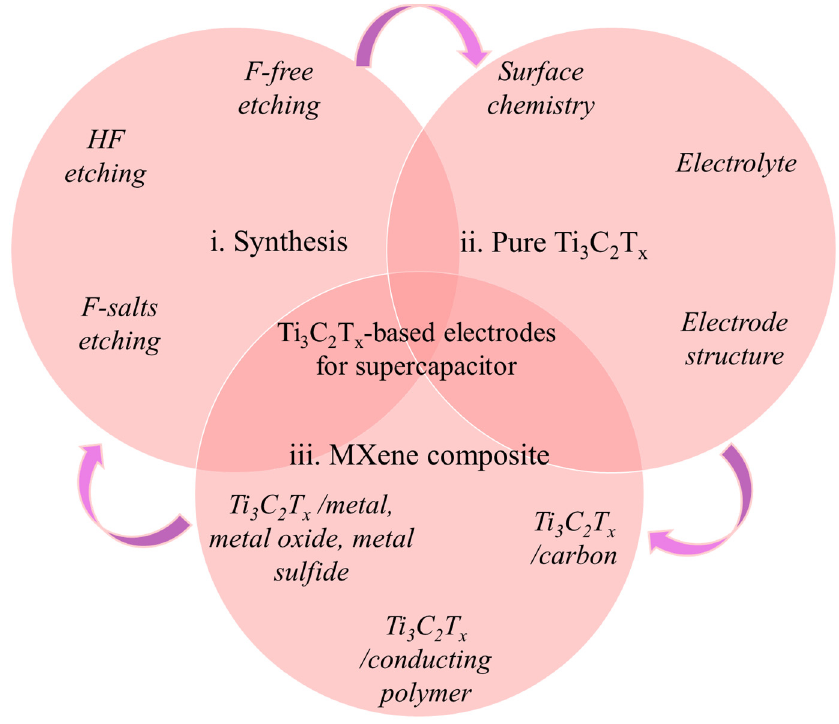
Figure 2. Overview of typical synthesis, variables affecting electrochemical achievement, and Ti 3 C 2 T x -based composite electrodes for SCs.